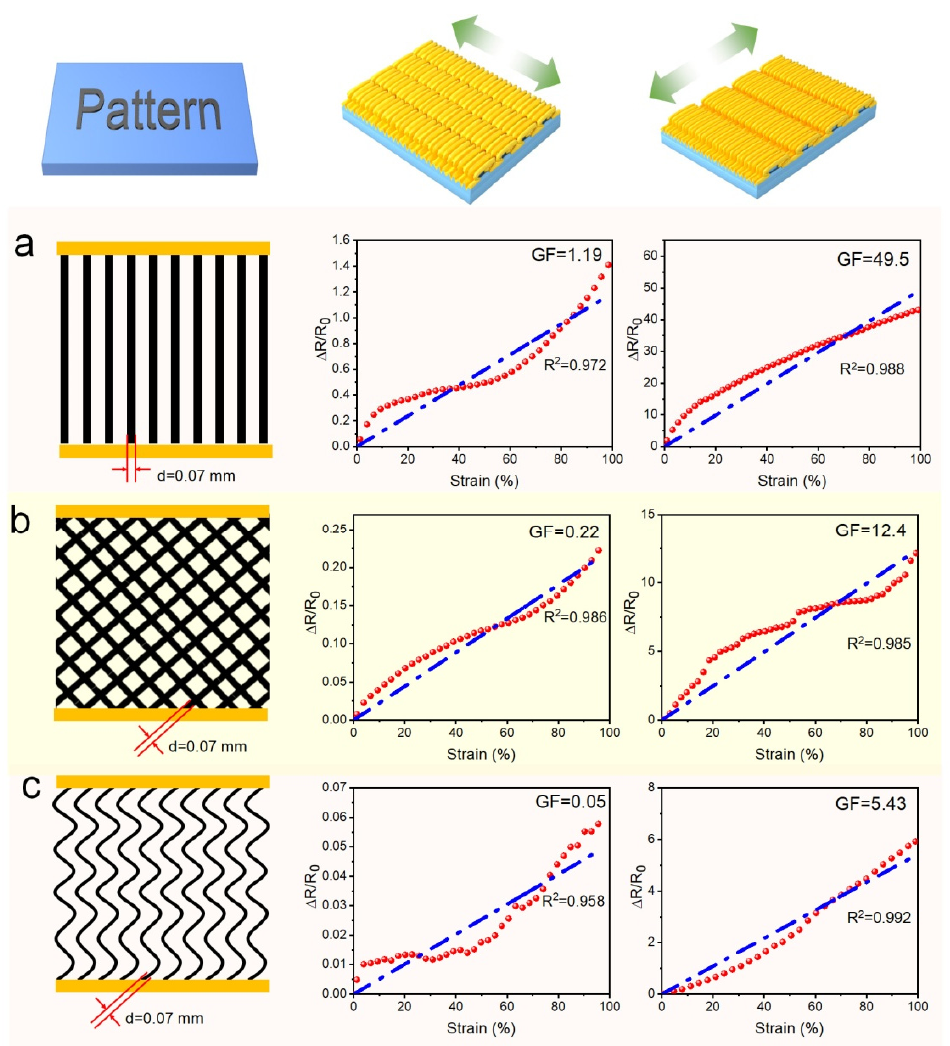
Figure 13. Strain-sensing properties along the directions of first- and second-grade wrinkles in PWG@R-5-60 of different patterns: ( a ) stripe, ( b ) grid lines (inclined), and ( c ) serpentine lines.